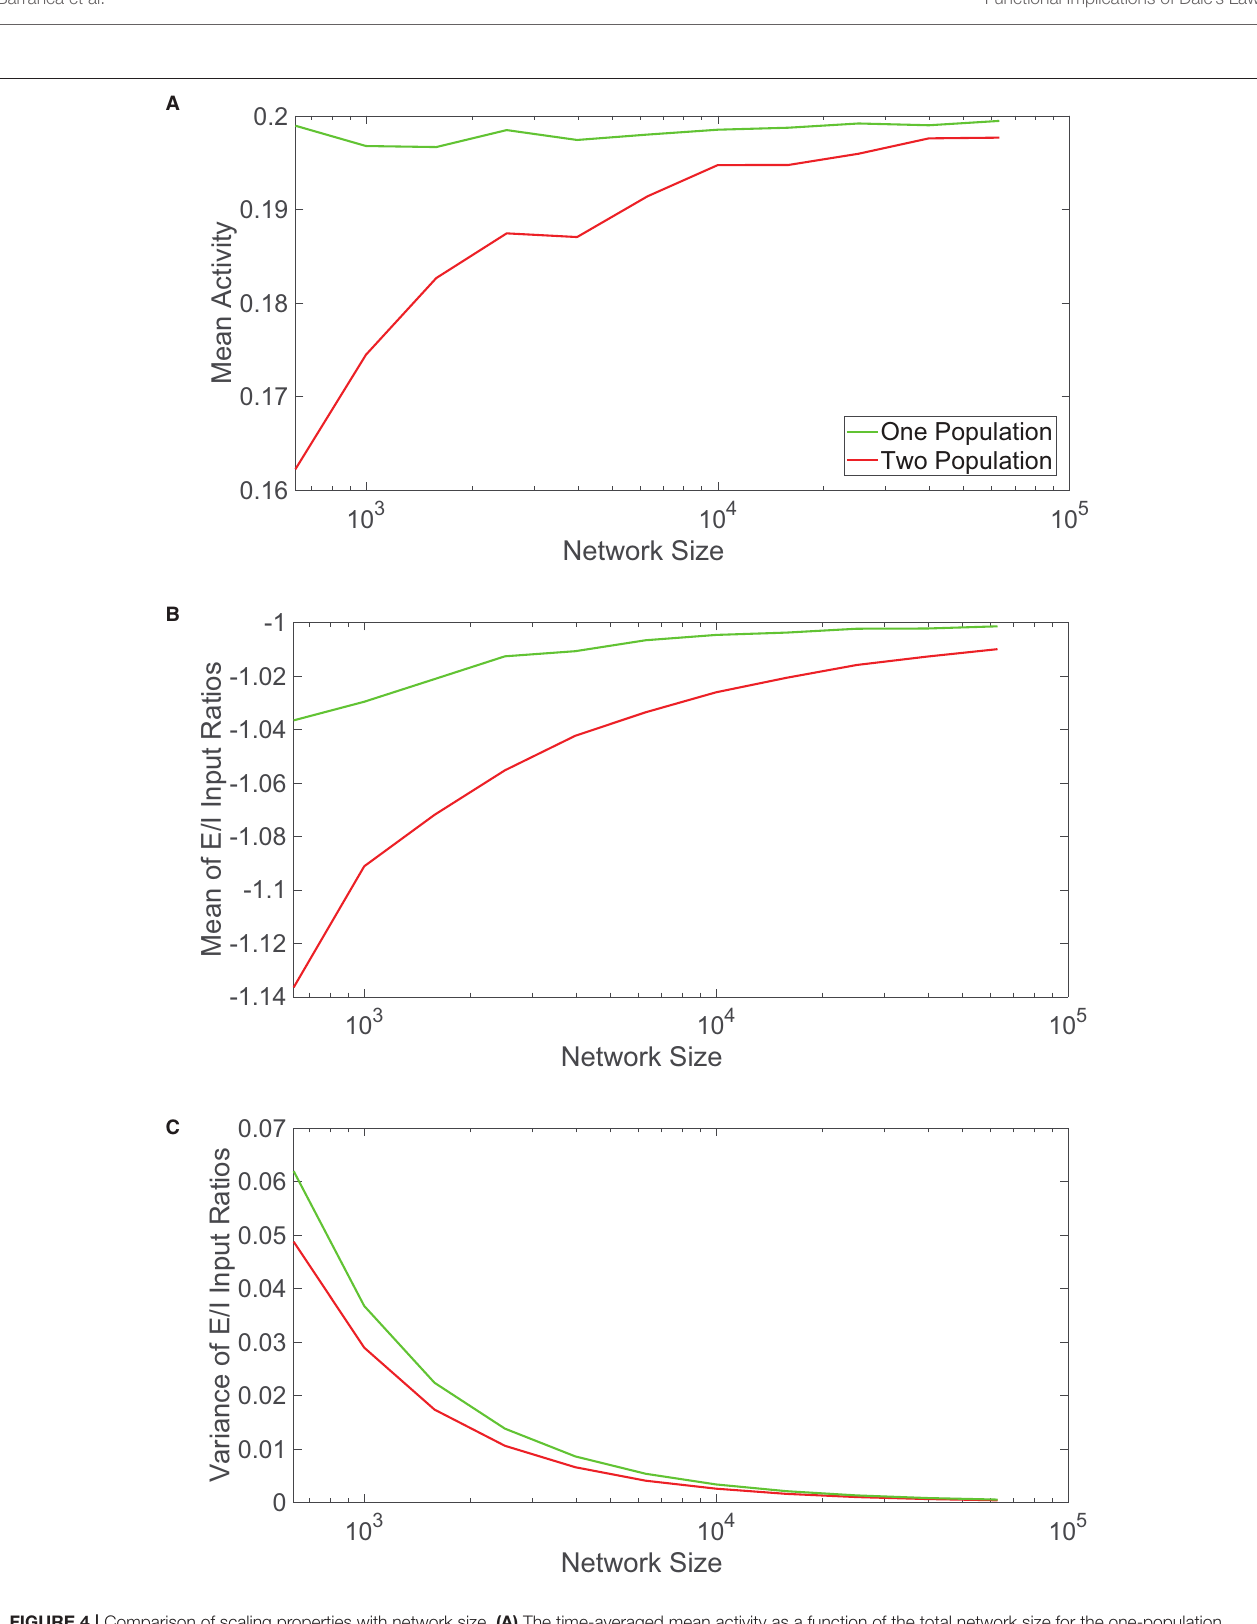
FIGURE 4 | Comparison of scaling properties with network size. (A) The time-averaged mean activity as a function of the total network size for the one-population (green) and two-population (red) networks. The mean activity for each population expected from theory is 0.2. (B) Mean of the ratio between time-averaged